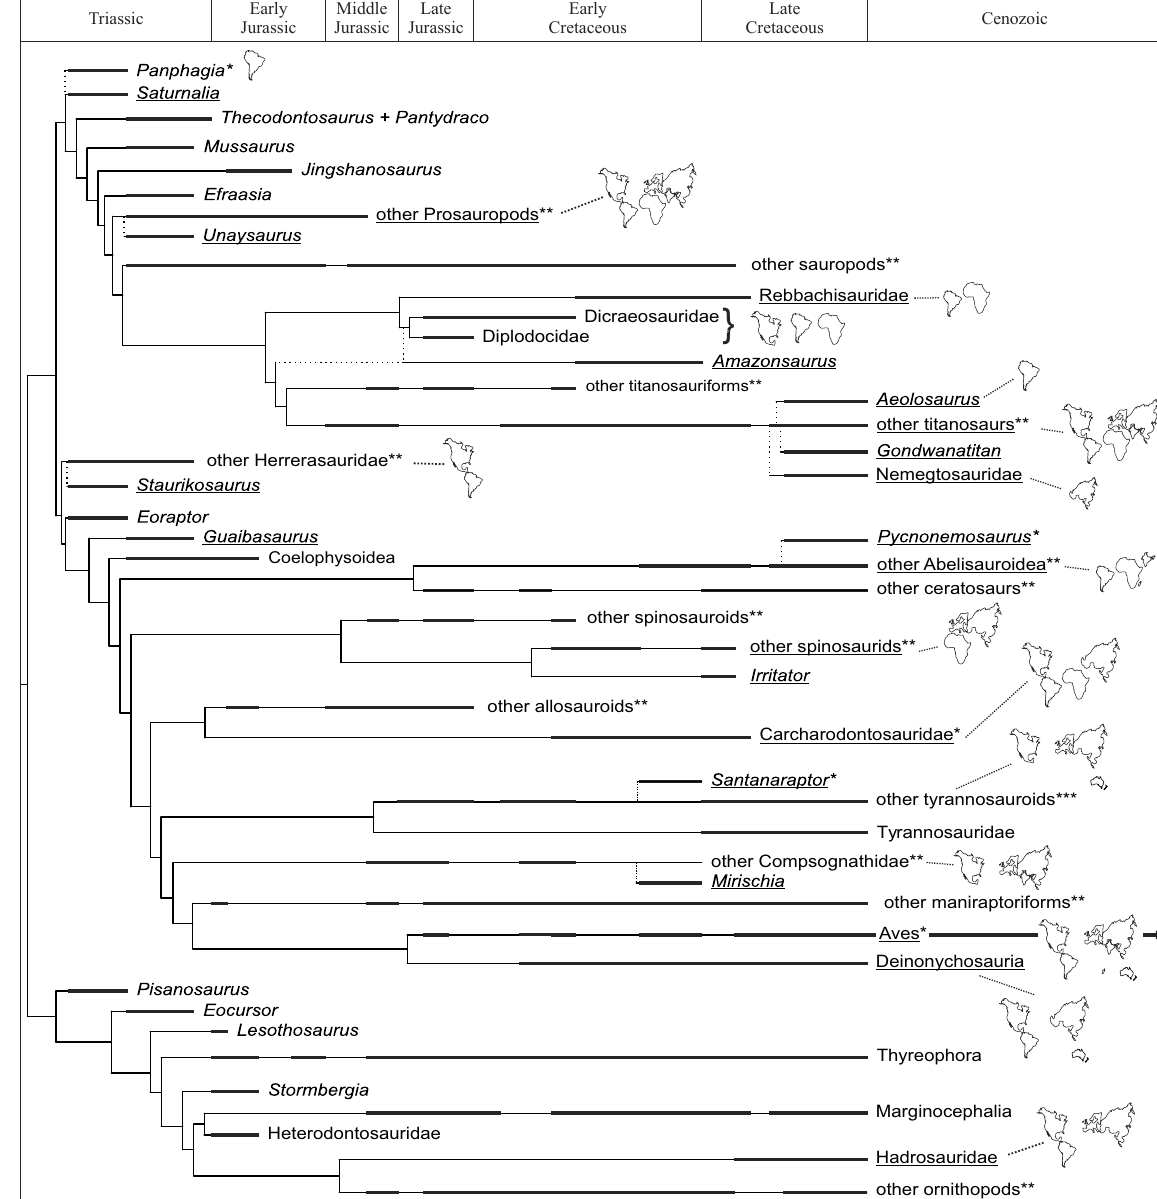
Fig. 2 – Cladogram depicting the phylogenetic relationships within dinosaurs, with emphasis on the Mesozoic record from Brazil. Modified from Lloyd et al. (2008). Thicker lines over branches represent temporal range of the clade. Underlined names refer to taxa recorded in Brazil, and maps denote the records in areas other than Brazil. (*) Taxa not present or with distinct composition in comparison with the original tree. (**) Paraphyletic groups. Some taxa from the original cladogram were omitted. Assemblage of supraespecific taxa followed the clade definitions from TaxonSearch (Sereno et al. 2005). Maps redrawn from Turner